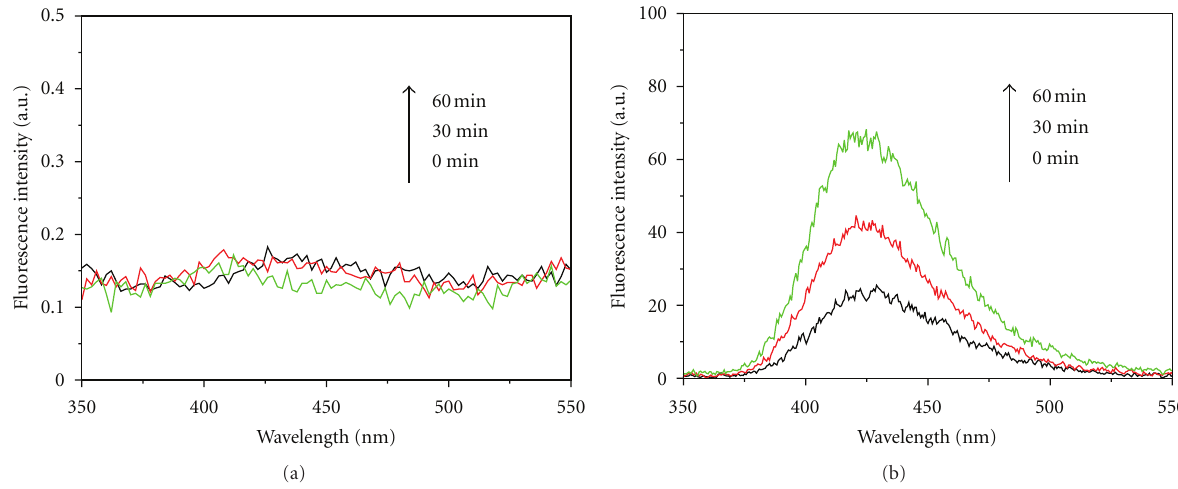
Figure 8: PL spectral changes observed during illumination of (a) as-prepared BiVO 4 and (b) TiO 2 sample in a 5 × 10 − 4 M basic solution of terephthalic acid (excitation at 315 nm). Each fluorescence spectrum was recorded every 30 min of visible light illumination.